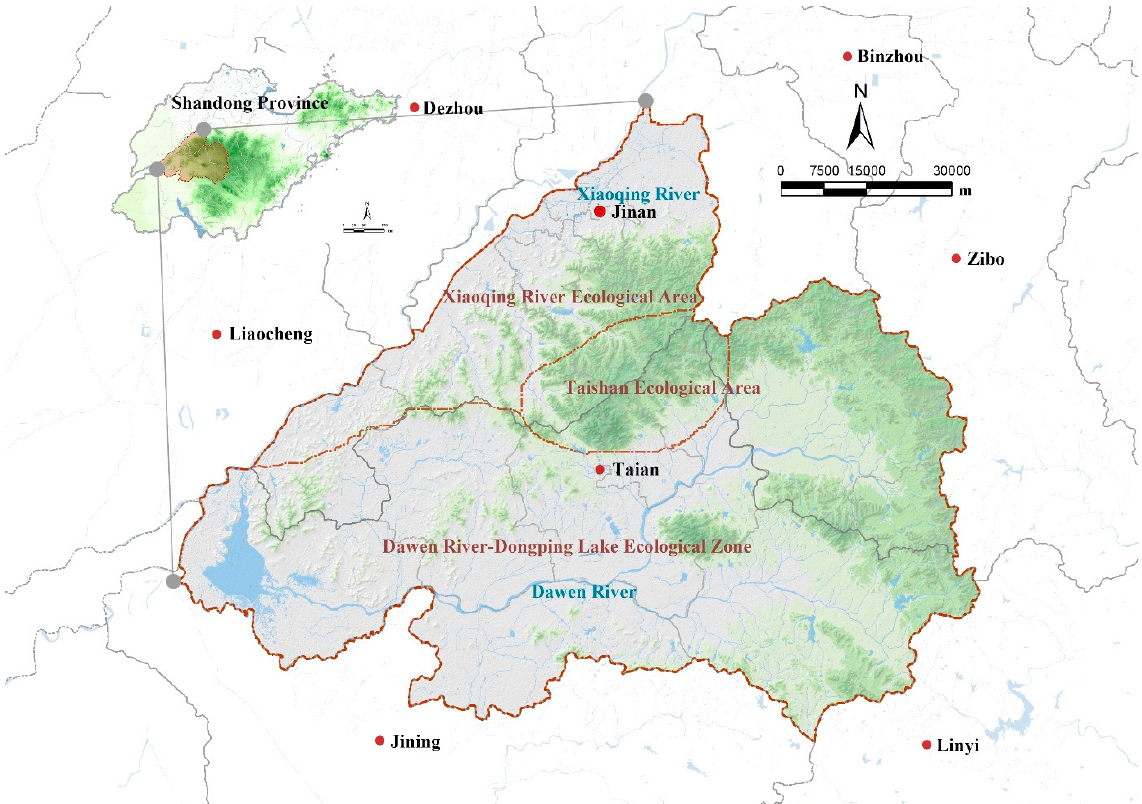
Figure 1. Location of the life community of mountains–rivers–forests–farmlands–lakes–grasslands in the Taishan area.